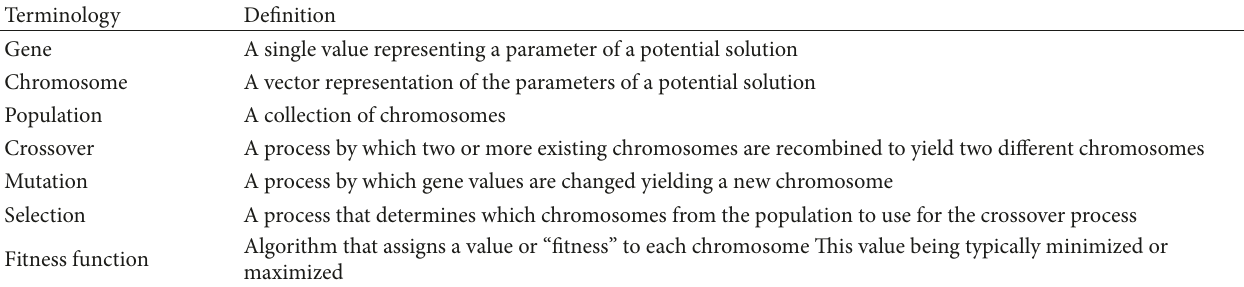
Table 1: Genetic algorithm terminology.